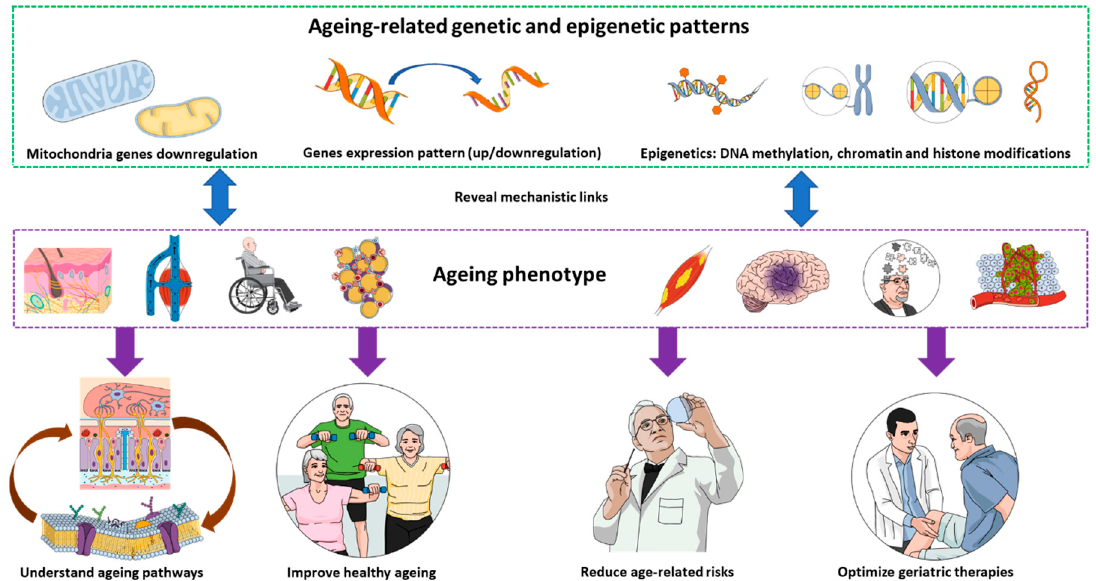
Figure 1. Exploring ageing-related genetic and epigenetic changes, and correlating them with ageing phenotype would have various implications in basic research, clinical studies, and geriatric healthcare.